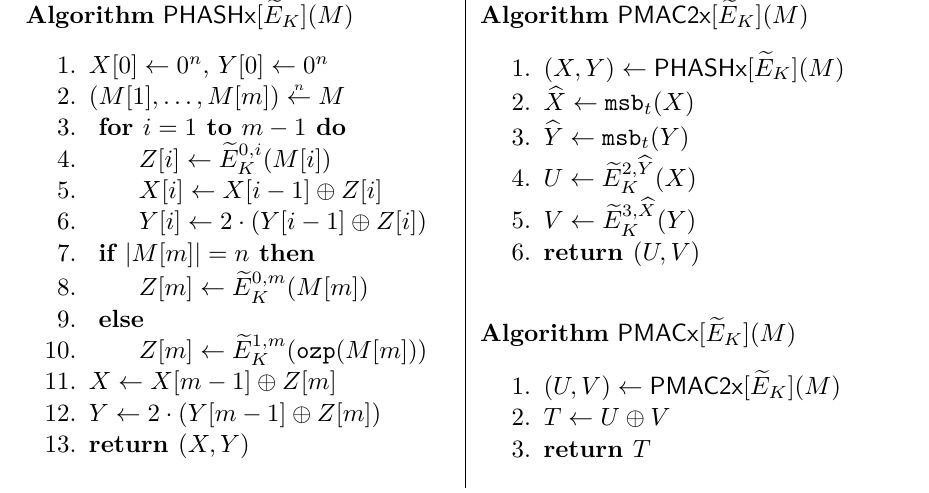
Figure 1: Definitions of PMAC2x and PMACx